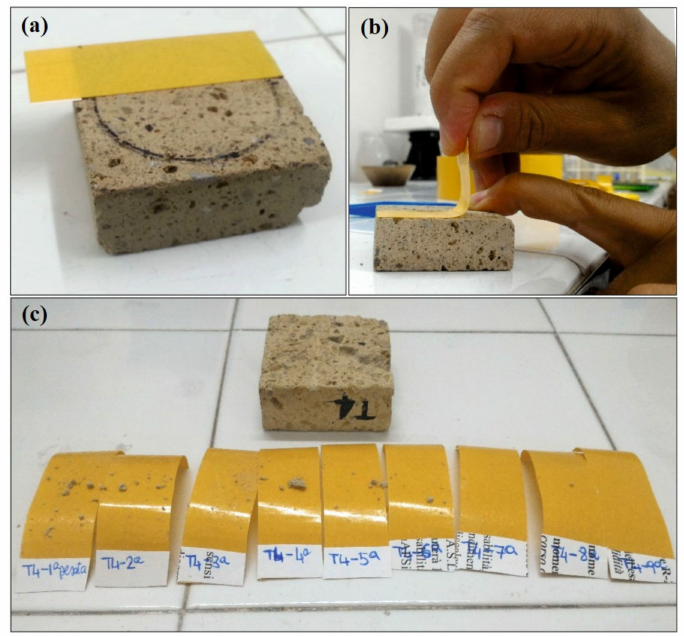
Figure 2. ( a ) Application of tape strips on sample; ( b ) removal, keeping a 90 ◦ contact angle; ( c ) tape strips after